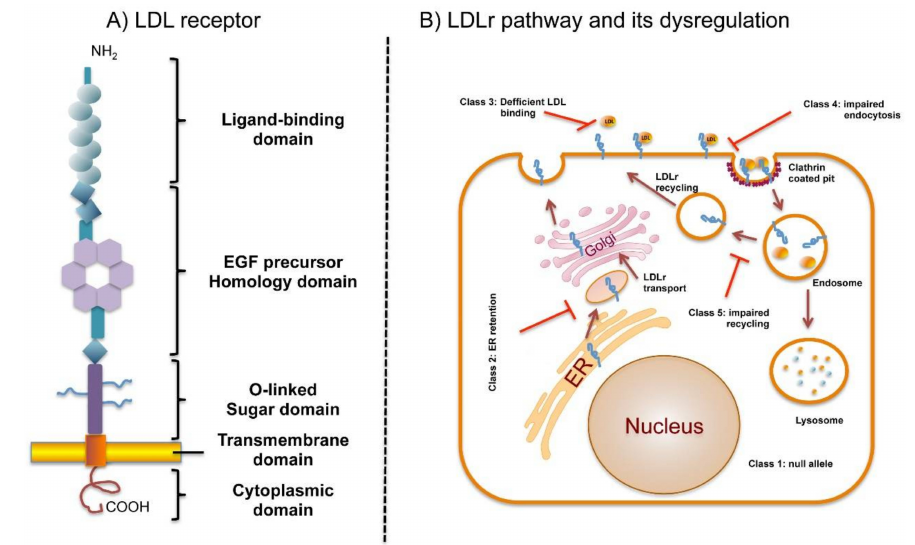
Figure 1. Domain organization of LDLr and LDLr pathway and its dysregulation by defective mutations. ( A ) Schematic representation of LDLr domains; ( B ) LDLr cycle. LDLr is synthesed at ER, transproted to Golgi where is further processed with glycosilations. Mature LDLr is transported to the plasma membrane, where the ligand-binding domain binds to the apo B100 moiety on LDL particles. The LDLr/LDL complex undergoes endocitosis and within the cell, LDL particle components are targeted for lysosomal degradation, whereas the LDLR is recycled to the cell surface. LDLr mutations affecting different LDLr cycle results in dysregulation of the